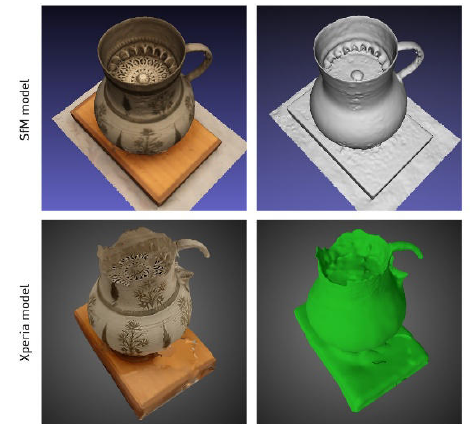
Figure 14. White ceramics Samovar SfM model in comparison to 3D Creator model